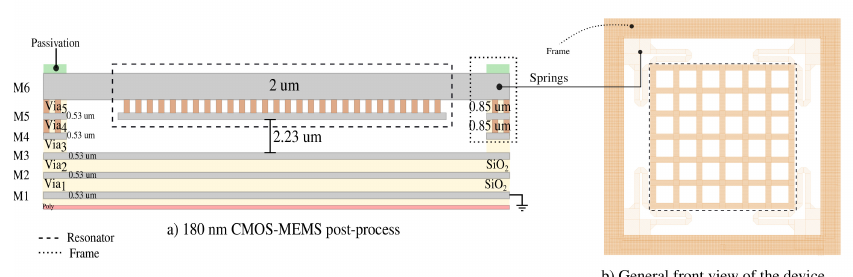
Figure 1. Schematic of the structural cross-section of the device in CMOS technology and the front view of it. Vertical scaling proportional to the metal stack of BEOL. ( a ) Cross-section of the 180 nm technology after post-processing, showing a resonant plate formed by two metals in which the springs are composed of the thicker metal of this technology. ( b ) Front view of the device, where the structure of the square plate, the springs, and the frame are